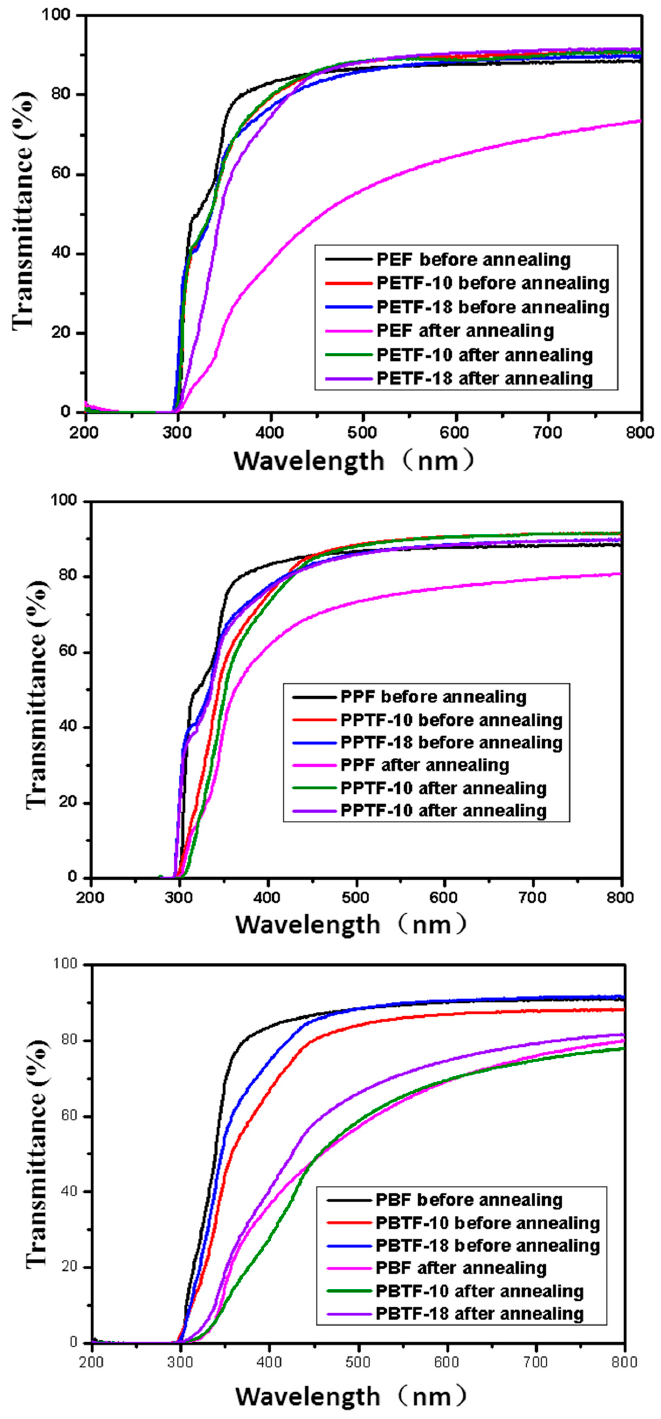
Figure 6. UV–visible spectra of PEF, PPF, PBF, and copolyesters modified with CBDO before and after annealing at 150 °C for 30 min.